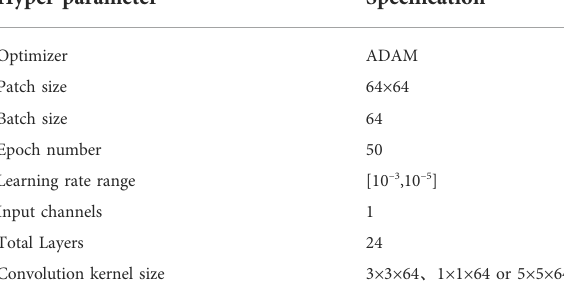
TABLE 2 Network parameters of